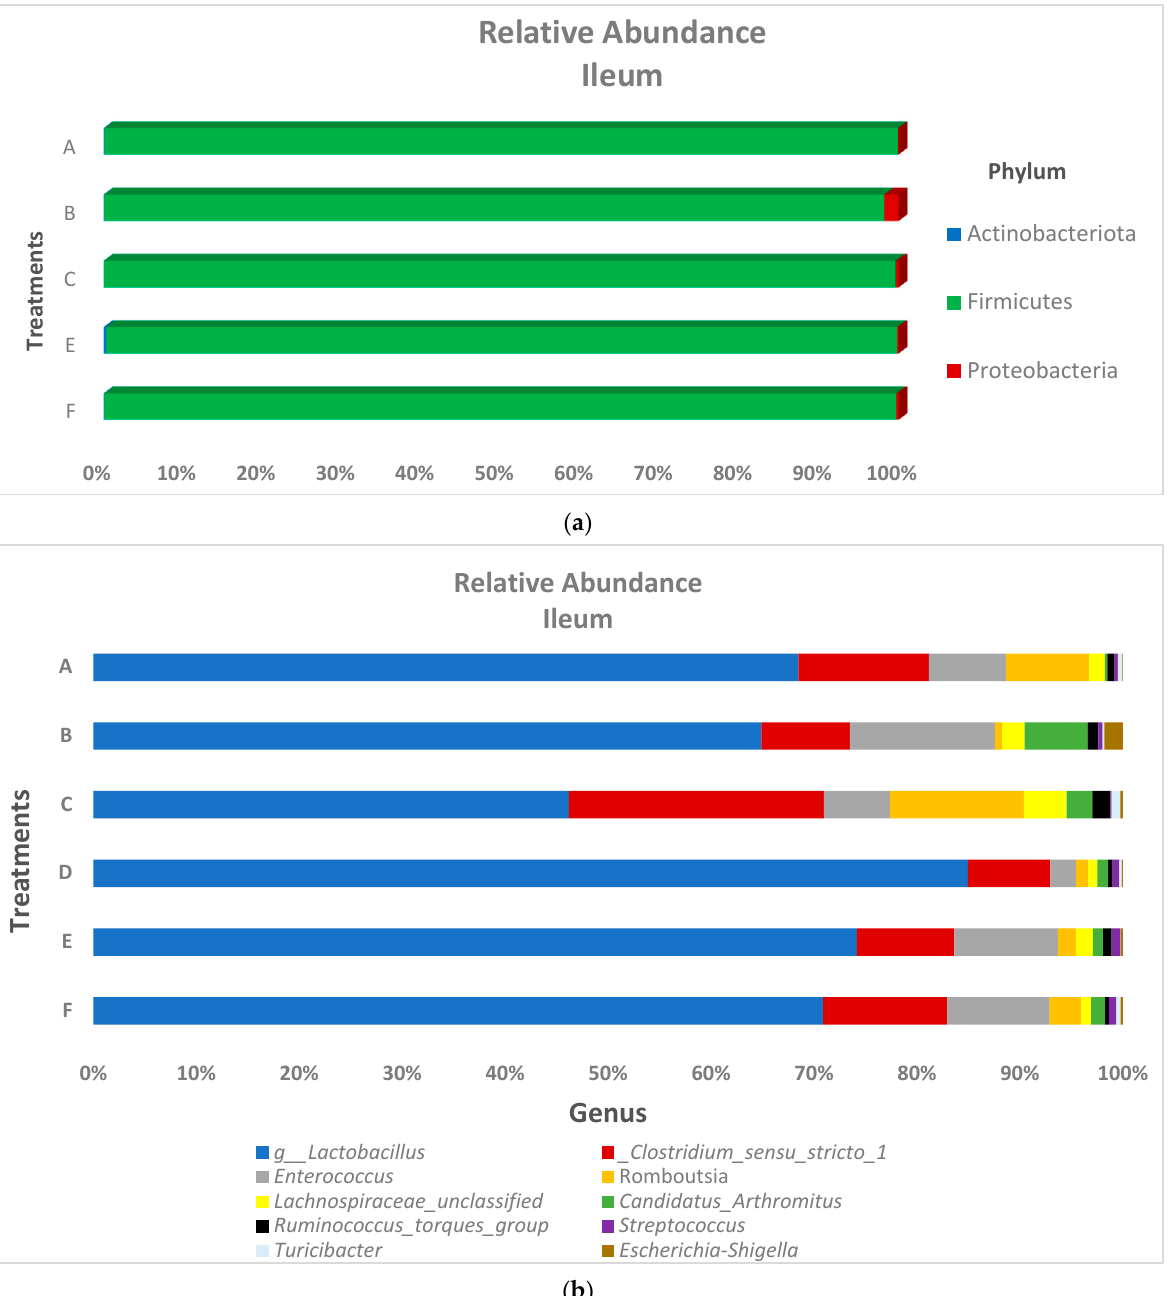
Figure 3. Ileal microbiota bacteria composition at the ( a ) phylum and ( b ) genus levels of broiler chickens subjected to different treatments groups. Treatments include (A) negative control treatment—chicks fed a basal corn-soybean meal-wheat-based diet; (B) in-feed antibiotics—chicks fed NC + 0.05% bacitracin methylene disalicylate; (C) in-water essential oil—chicks supplied the essential oil via the water route at the recommended dosage of 250 mL/1000 L of drinking water; (D) in ovo saline treatment—eggs injected with 0.2 mL of physiological saline (0.9% NaCl); (E) in ovo essential oil treatment—eggs injected with 0.2 mL of a saline + essential oil blend mixture at a dilution ratio of 2:1l; and (F) in ovo + in-water essential oil treatment—chicks offered the essential oil blend via the in ovo and in water route,